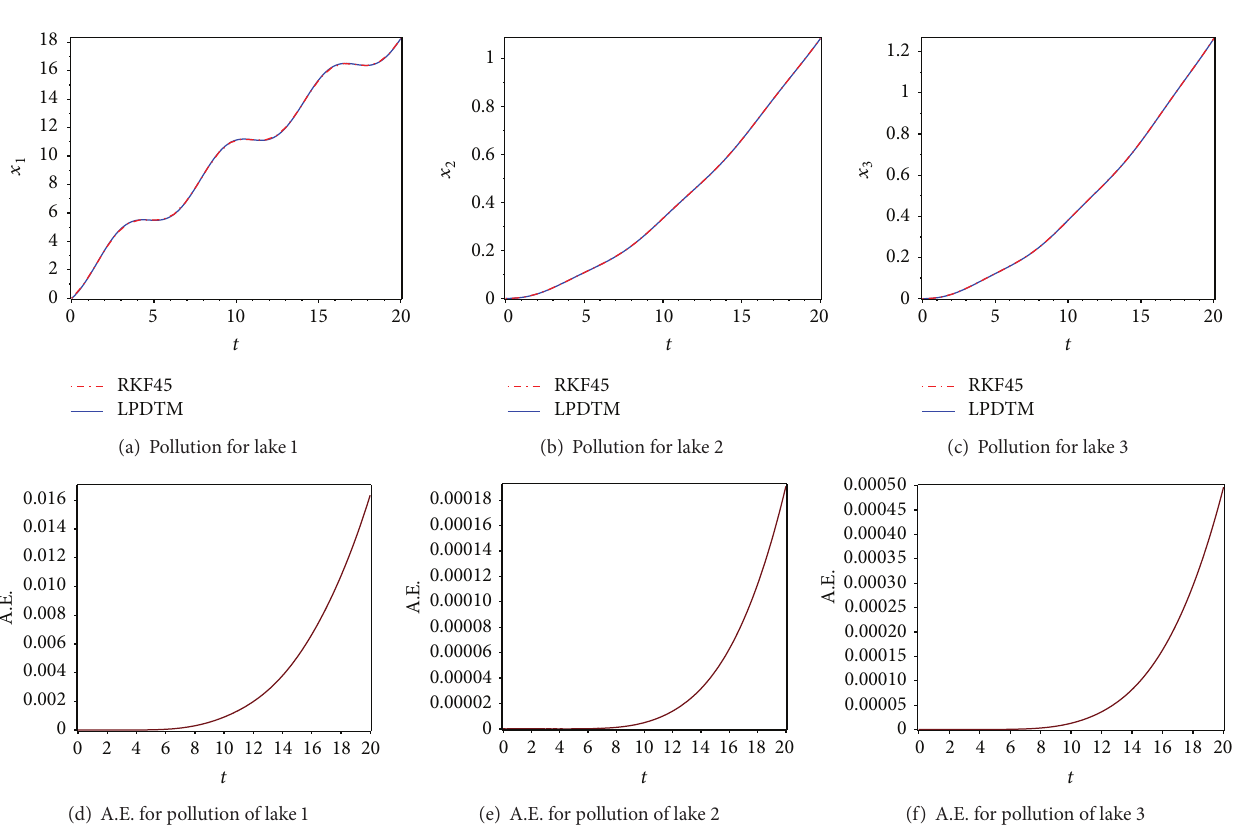
Figure 2: Periodic input signal and absolute error (A.E.) of approximations. The time 𝑡 is expressed in years.